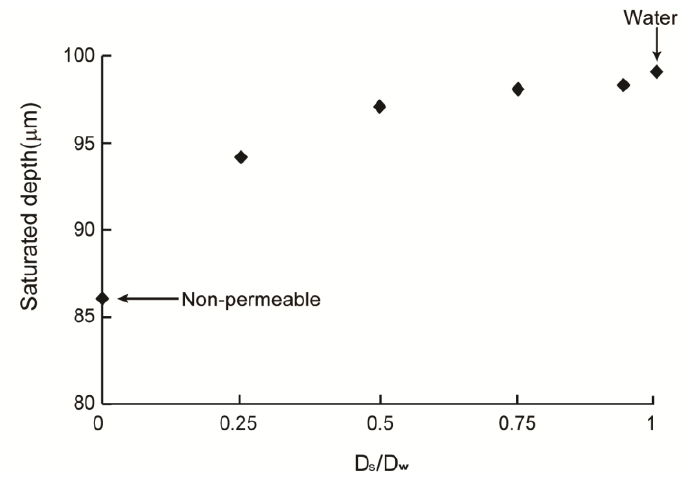
Figure 4. Saturated depth according to strut diffusion